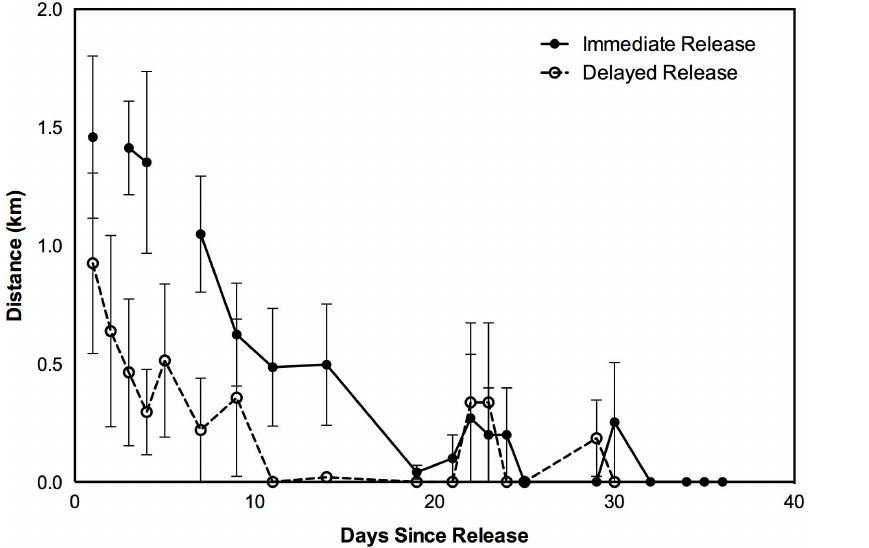
Figure 2. The distance between successive daily fixes for delayed and immediate release burrowing bettongs after access to the Northern Paddock. Delayed release bettongs were kept in a release pen for three weeks prior to release. Bars denote 1 standard error.